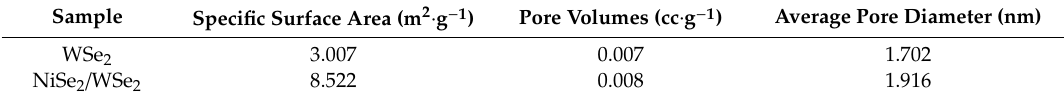
Table 1. Specific surface area, pore volume, and pore diameter of WSe 2 and NiSe 2 / WSe 2.